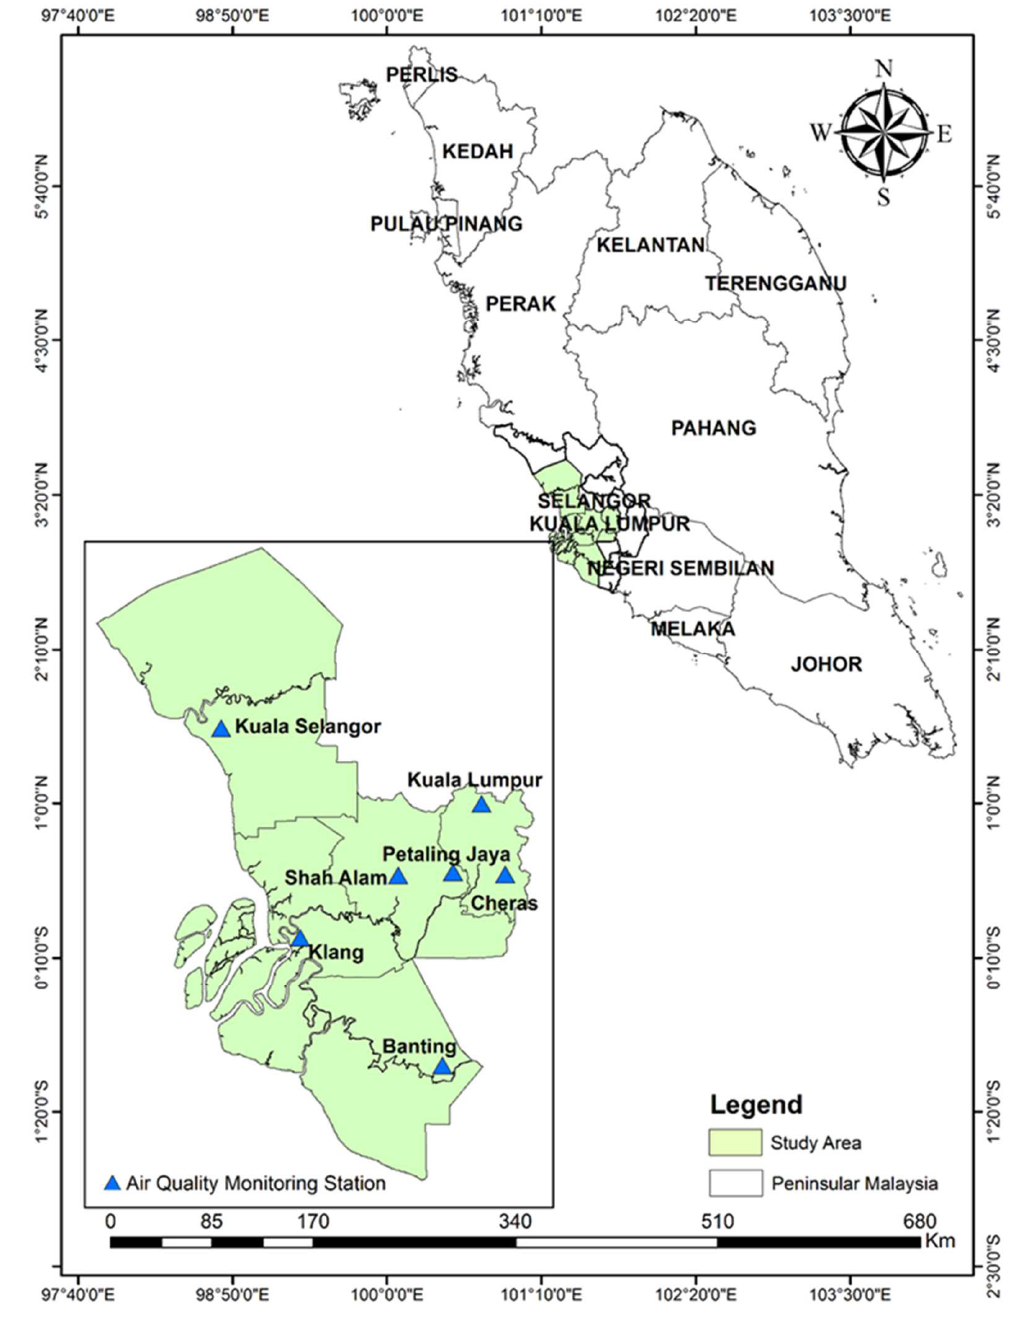
Figure 1. Sites of the studied stations in Peninsular Malaysia.